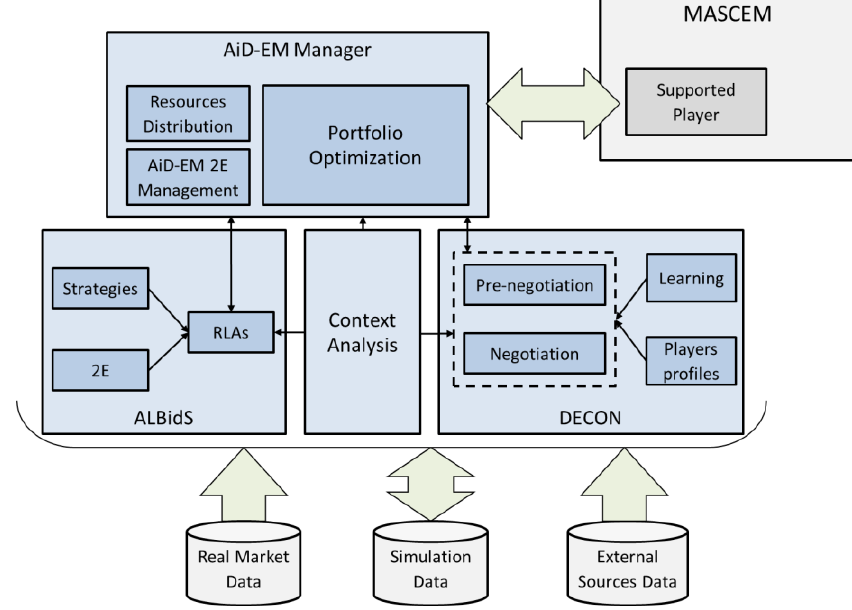
Figure 2. AiD-EM multi-agent architecture, adapted from [23].